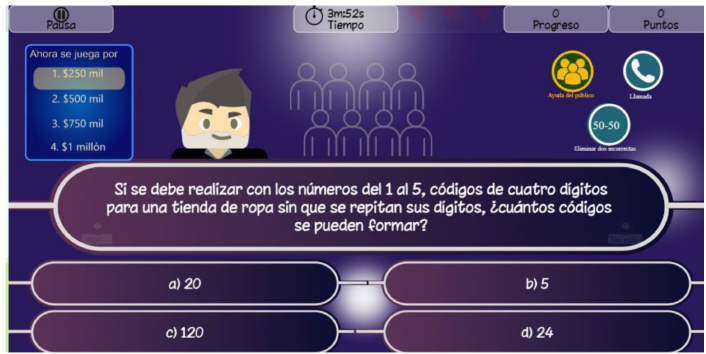
Figure 20. Multiple-choice Questions